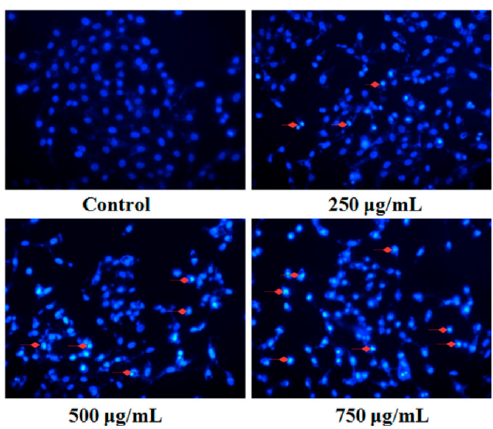
Figure 4. Fluorescent staining of MG63 cells with DAPI. Cells treated with serial concentrations of PZH (250, 500 and 750 μ g/mL) for 24 h were stained with DAPI solution. Apoptotic body was labeled with red arrows.